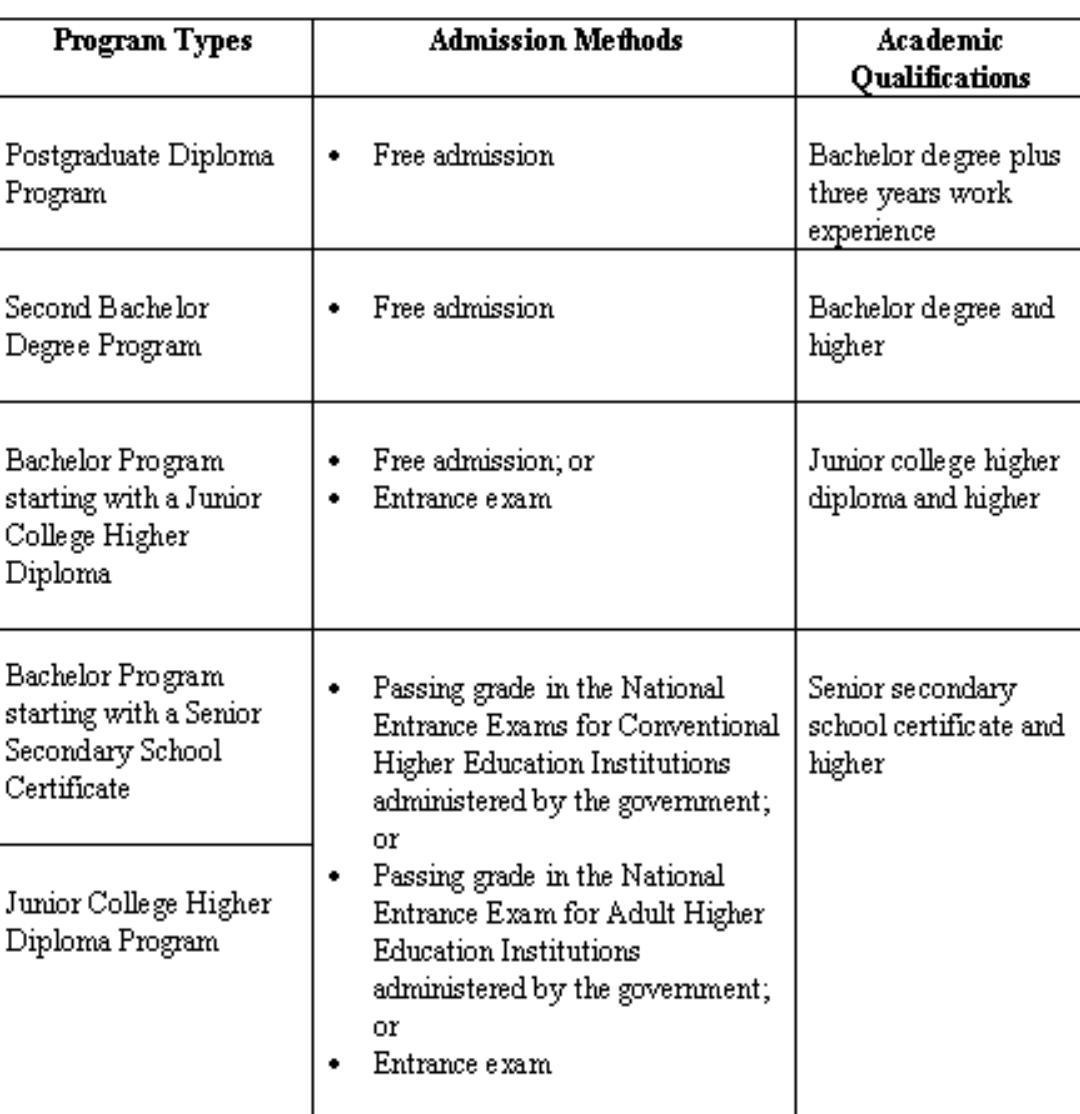
Table 4: Admission Policy for Web-based Educational